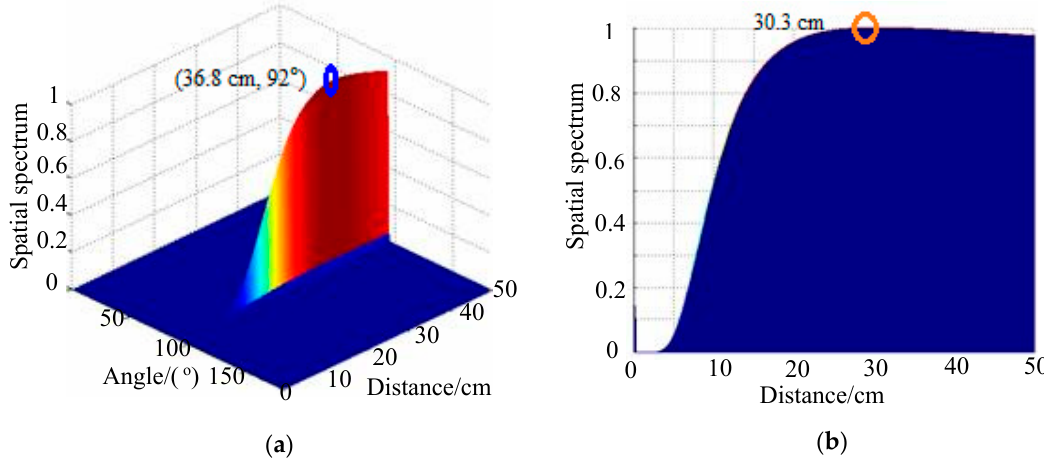
Figure 7. Spatial spectra of two methods under deformation degree 5 when PZTA was excited: ( a ) 2D-MUSIC algorithm; ( b ) TAM-MUSIC method.